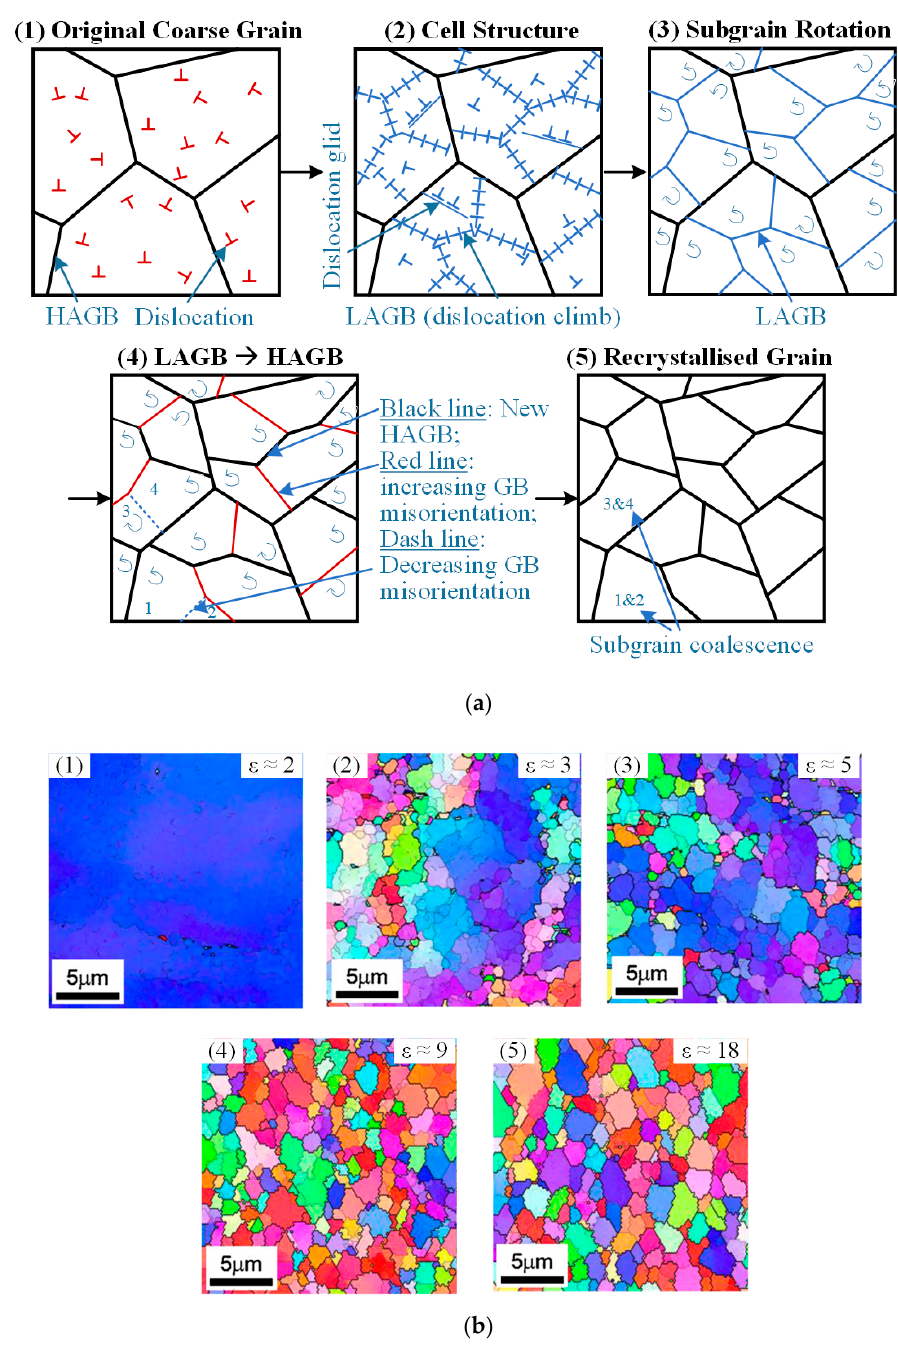
Figure 2. Development of new grains during CDRX: ( a ) schematic illustration, ( b ) experimental observation (EBSD IPF maps) of as-annealed pure Al (99.99%) deformed by high-pressure torsion at room temperature (Reproduced with permission from Elsevier